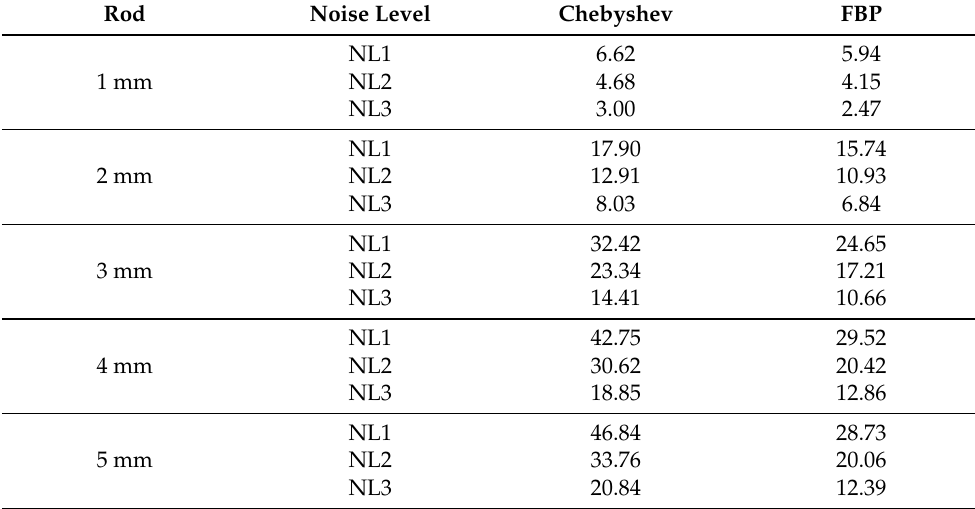
Table 2. Contrast-to-noise-ratio ( CNR ) measurements for the hot region of the simulated IQ phantom for Chebyshev and FBP reconstructions, for all hot fillable rods, for all noise levels. Rod Noise Level Chebyshev